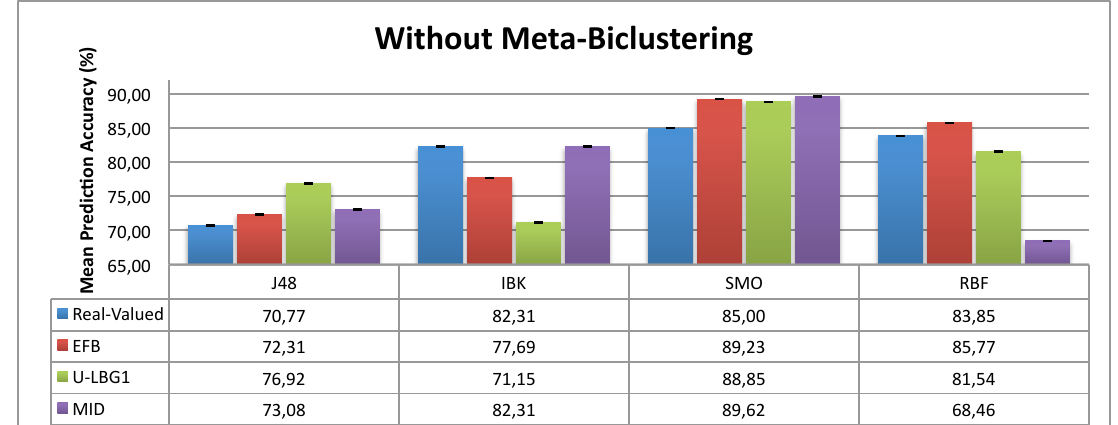
Figure 4: Mean prediction accuracy and standard deviation resulting from the classification with- out Meta-Biclustering: real-valued and discretized data (EFB, U-LBG1, and MID using 3 bits). Classification is achieved with Weka classifiers: J48 (DT), IBK (kNN), SMO (SVM), and RBF. The 5 x 4-fold CV evaluation , with the same partitions as in [7], is